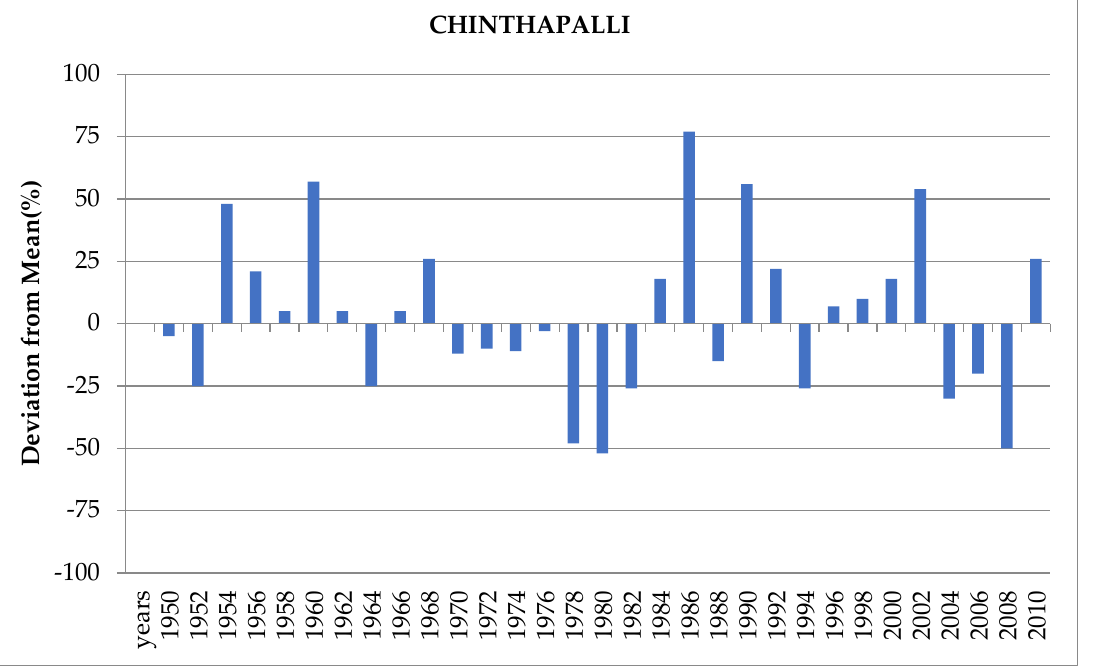
Figure 14. Chinthapalli. Figure 14.